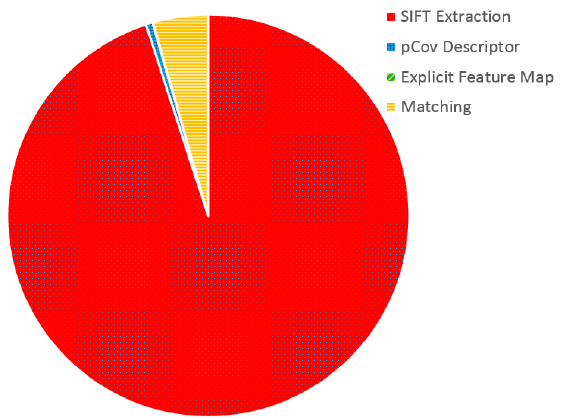
Figure 6. Evaluation of the computational demands of the different steps of our algorithm. Note that the time required by the Explicit Feature Map is negligible and cannot be seen in the chart due to the scale of the plot.